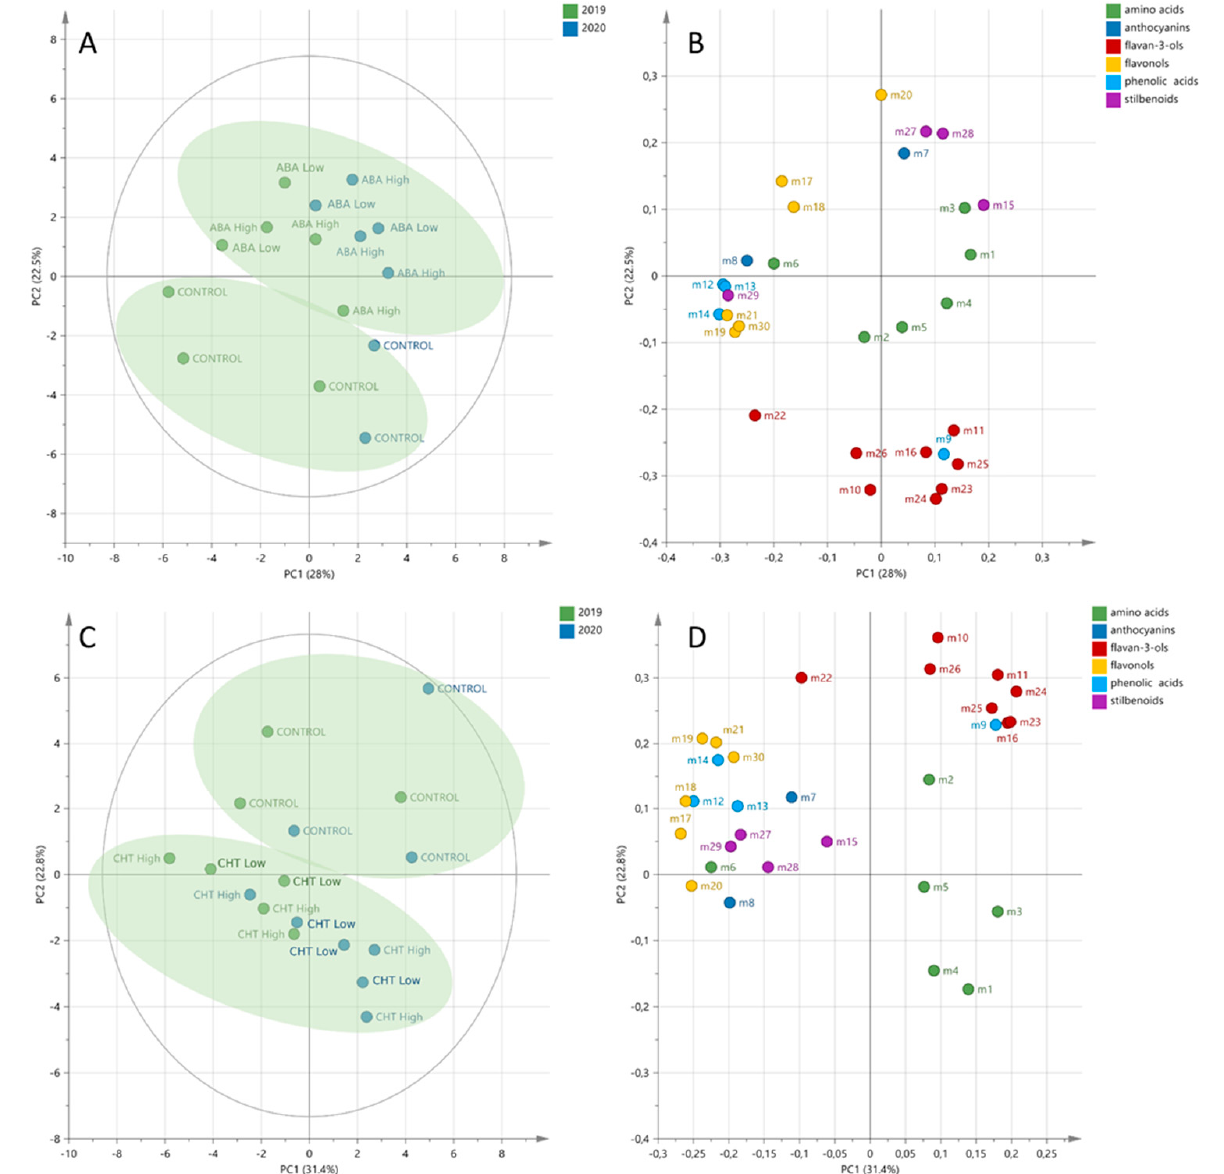
Figure 2. Unsupervised classification using principal component analysis on metabolomic data from grape berries of cultivar Savvatiano at veraison stage in 2019 and 2020 treated with abscisic acid ( A , B ) and chitosan ( C , D ). Samples in the score plots ( A , C ) were colored according to the vintage, and variables in loading plots ( B , D ) were colored according to the metabolic class. Numbers indicate the ID of metabolites, as follows: L-proline (m1); L-leucine (m2); L-isoleucine (m3); L-phenylalanine (m4); L-tyrosine (m5); L-tryptophan (m6); cyanidin-3- O -galactoside (m7); peonidin-3- O -(6- p -coumaroyl- glucoside) (m8); gallic acid (m9); catechin (m10); epicatechin (m11); coutaric acid (m12); caftaric acid (m13); fertaric acid (m14); E-piceid (m15); catechin-gallate (m16); kaempferol-3- O -glucoside (m17); quercetin-3- O -glucoside (m18); quercetin-3- O -glucuroside (m19); quercetin-3- O -glucuronide (m20); myricetin − glucoside (m21); procyanidin B1 (m22); pro- cyanidin B2 (m23); procyanidin B3 (m24); procyanidin B4 (m25); procyanidin-gallate (m26); E − resveratrol (m27); E − piceatannol (m28); E − ε − viniferin (m29); kaempferol − 3 − O − rutinoside (m30).